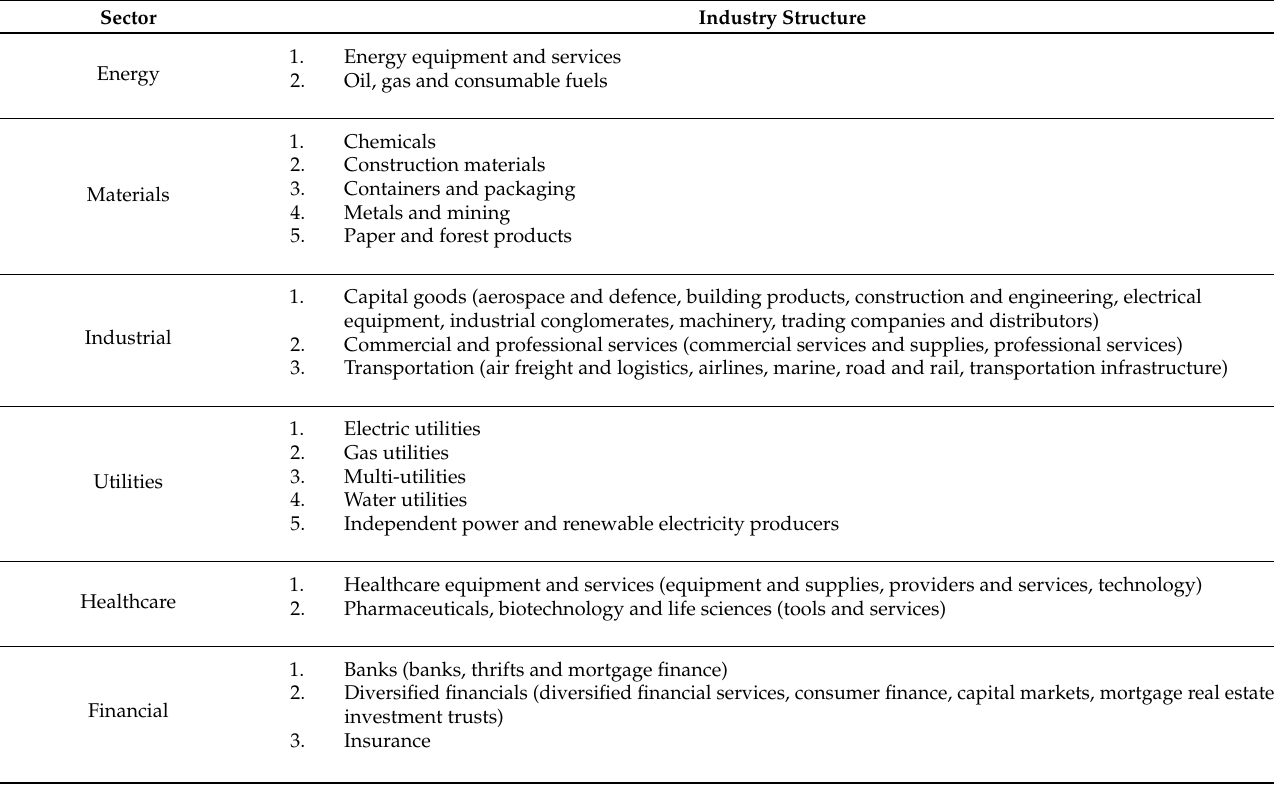
Table A1. Global Industry Classification Standard (GICS): stock market sector